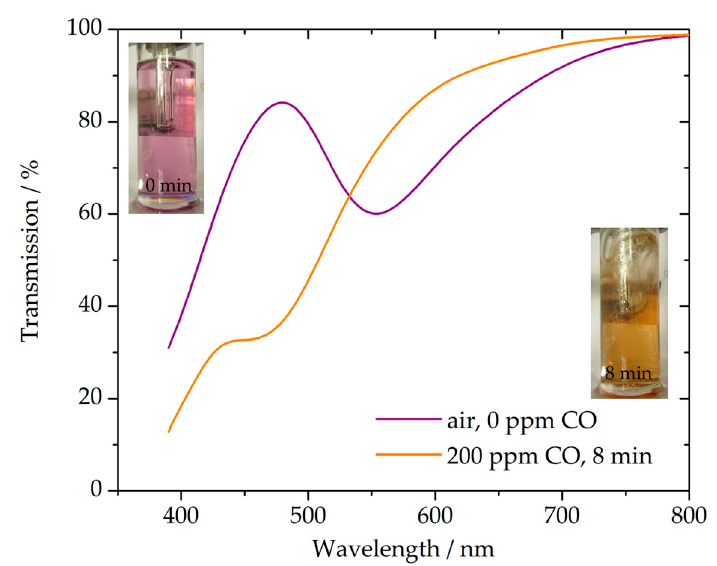
Figure 2. Spectral response of rhodium complex 1 ∙ (A) 2 (11 mg dissolved in 8 mL CHCl 3 ) before (purple) and after exposure to CO (yellow)